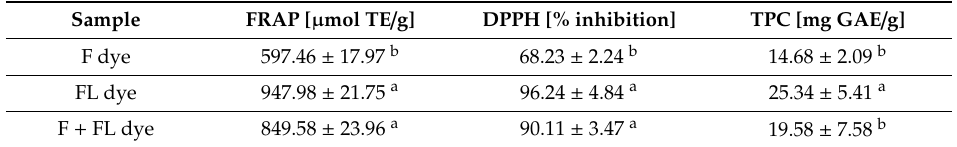
Table 4. Results of the analysis of antioxidant properties of the tested